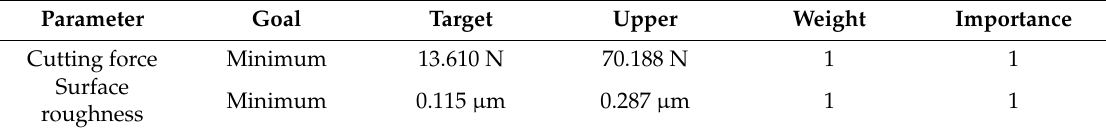
Table 9. Response optimization.